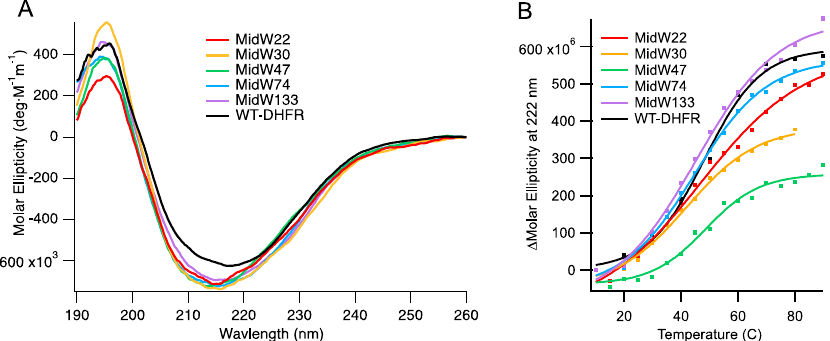
Figure 2. ( A ) Circular dichroism (CD) spectra of wild-type DHFR (wt-DHFR) and the five midW mutants. Trp side chains can impact the CD spectra. Wt-DHFR has five trp residues, whereas the midW mutants have only one trp each. Despite the lower molar ellipticity of the mutants compared to the wild type, the CD spectra show that the mutants are folded enzymes with both alpha helices and beta sheets. ( B ) Thermal melts of wt-DHFR and the midW mutants. midW: DHFR mutants, each with a single tryptophan residue. Table 1. Melting temperatures of wild-type (WT) and midW mutants as determined by loss of ellipticity at 222 nm. Enzyme